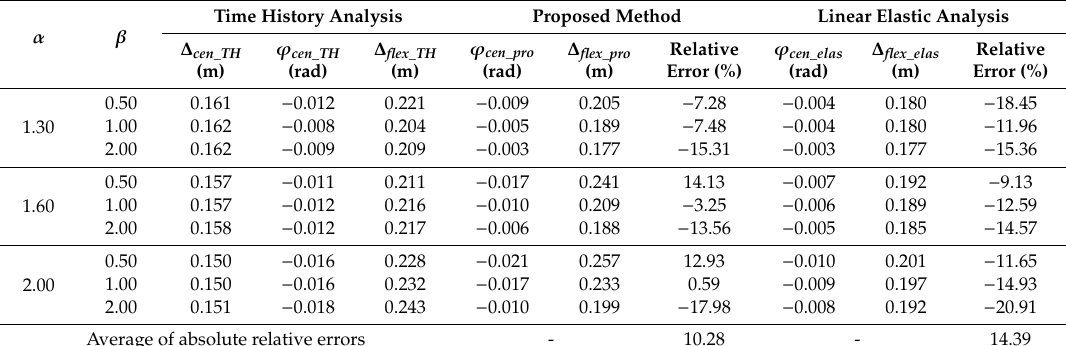
Table 6. Results of the time history analysis, the proposed method and the linear elastic response.